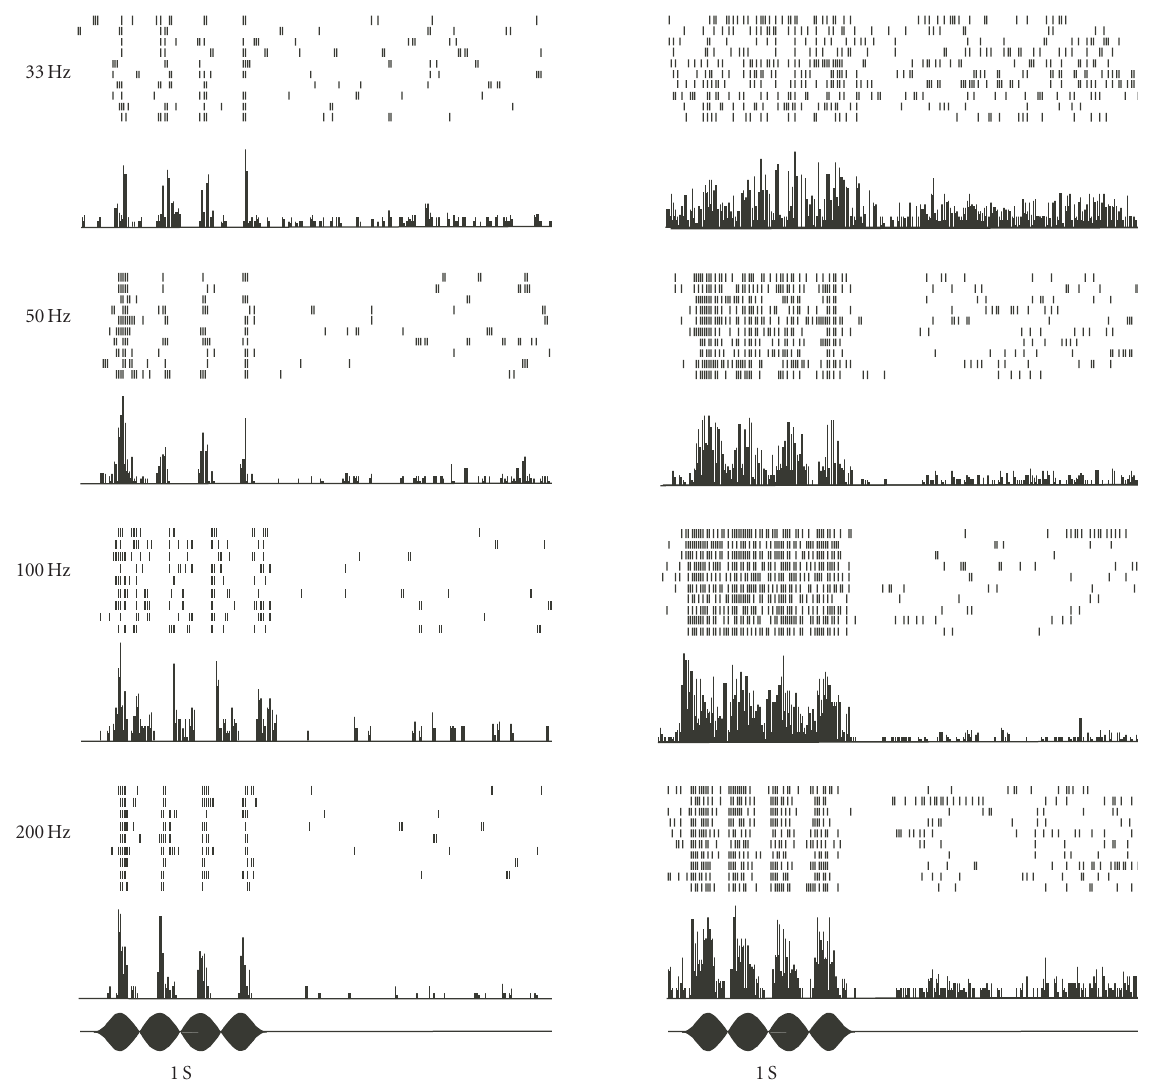
Figure 6: Discharge patterns of two MON units (left and right) in response to 4Hz AM stimuli (CF 33, 50, 100 or 200 Hz). In this and the following figure, each graph shows a dot display illustrating spike activity to ten stimulus presentations and a peri-stimulus time (PST) histogram (bin width 10ms). The envelopes of the stimulus traces are shown at the bottom. Peak-peak displacement amplitude of the sphere was 160 μ m. Note that the units clearly phase coupled to the 4Hz AM